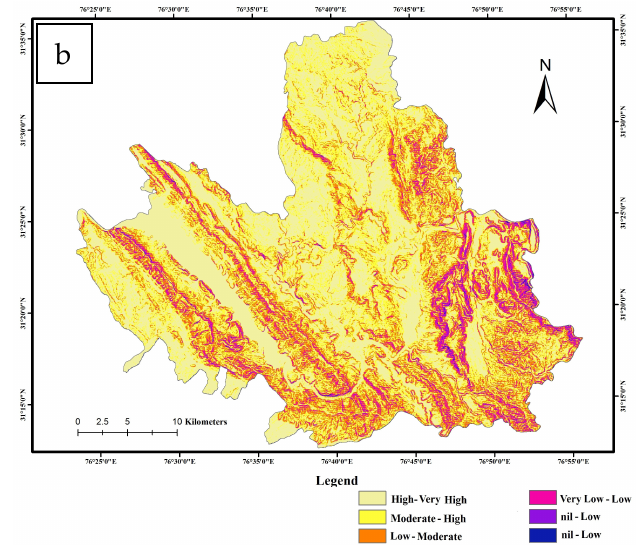
Figure 8. ( a ) Slope map of Bilaspur district; ( b ) Slope index map of Bilaspur district.